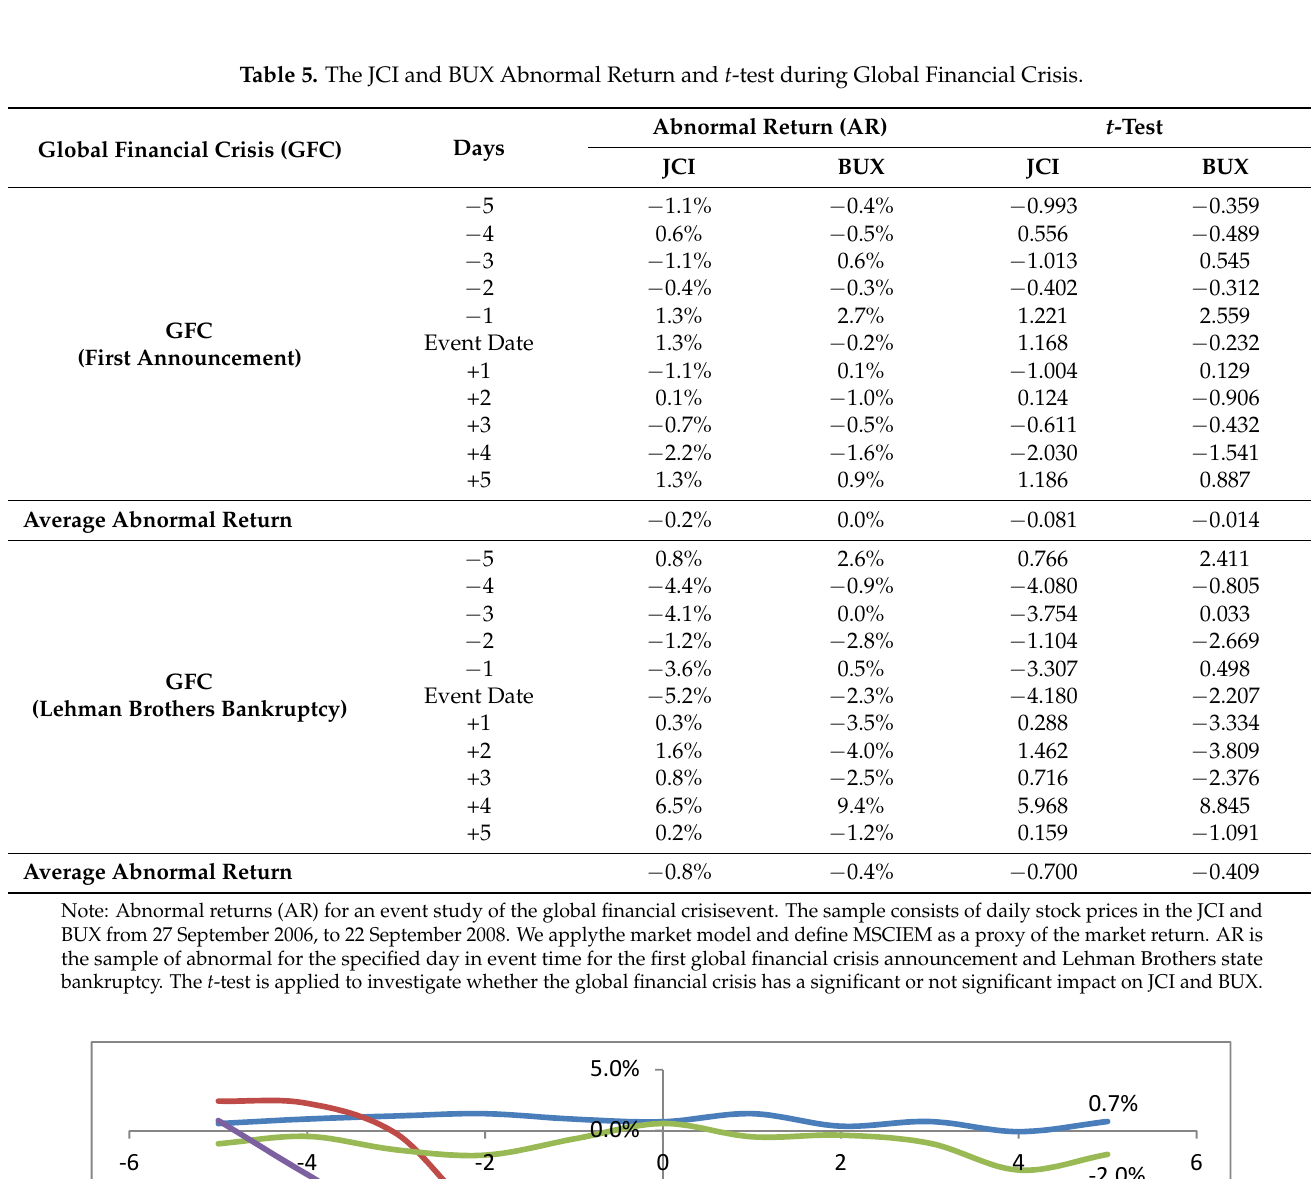
Table 5. The JCI and BUX Abnormal Return and t -test during Global Financial Crisis.